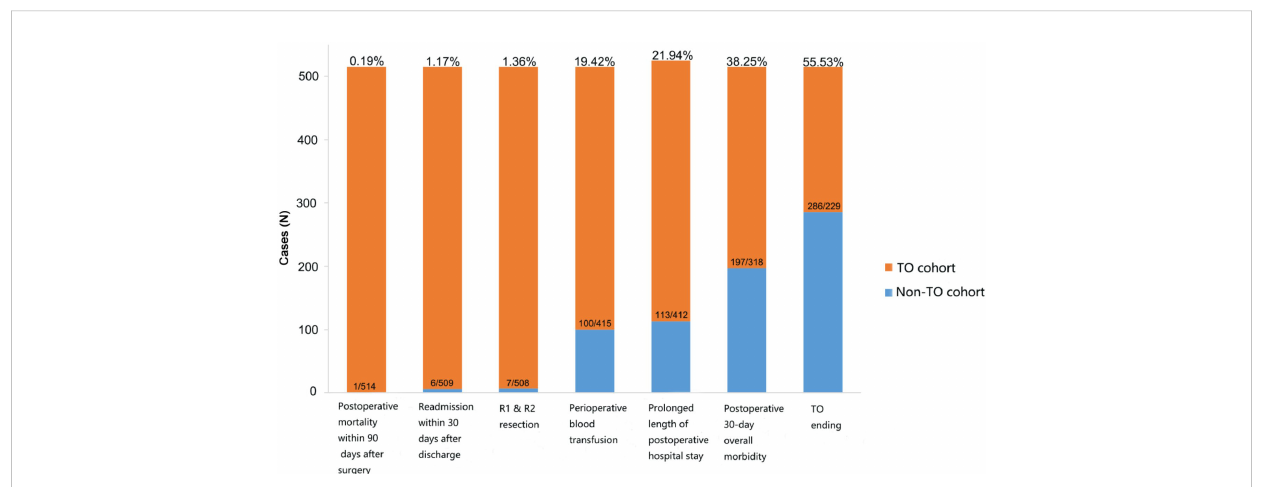
FIGURE 1 Distribution of outcome measures between the two